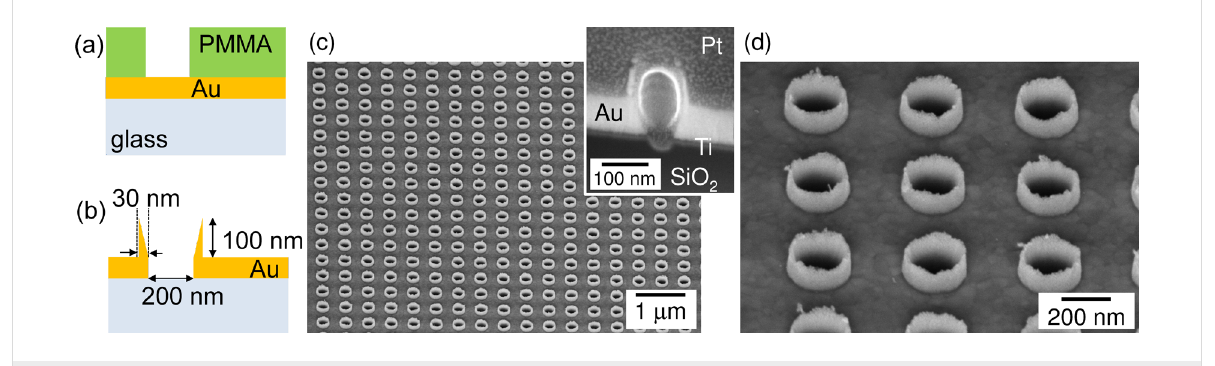
Figure 1: Illustration of the nano-well fabrication by (a) dry plasma etching of Au-film and PMMA mask, which results in Au re-sputtering and (b) formation of a nano-well around the rim of the hole. The experimental outcome is shown as (c) SEM image of the 3D Au nano-wells array; in (d) the magnified slanted view shows details of the nano-well edges. The inset in panel (c) shows the cross-section of a nano-well after deposition of a protective Pt